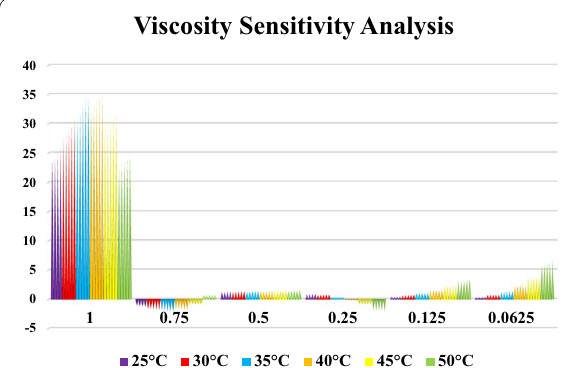
Fig. 14 Viscosity sensitivity analysis for all data at different laboratory